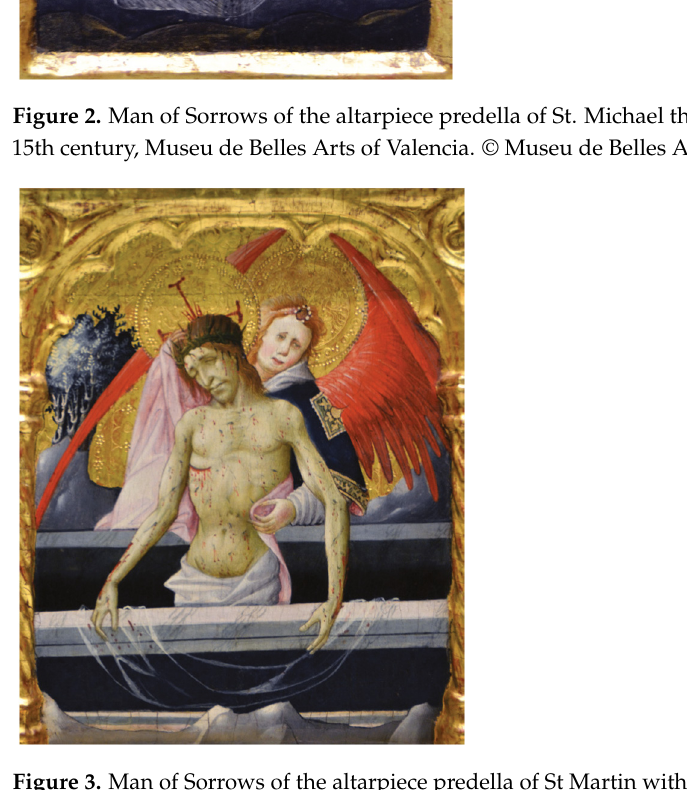
Figure 3. Man of Sorrows of the altarpiece predella of St Martin with St. Ursula and St. Anthony the Great, Gonçal Peris Sarrià, ca. 1437–1440, Museu de Belles Arts of Valencia. © Museu de Belles Arts of Valencia